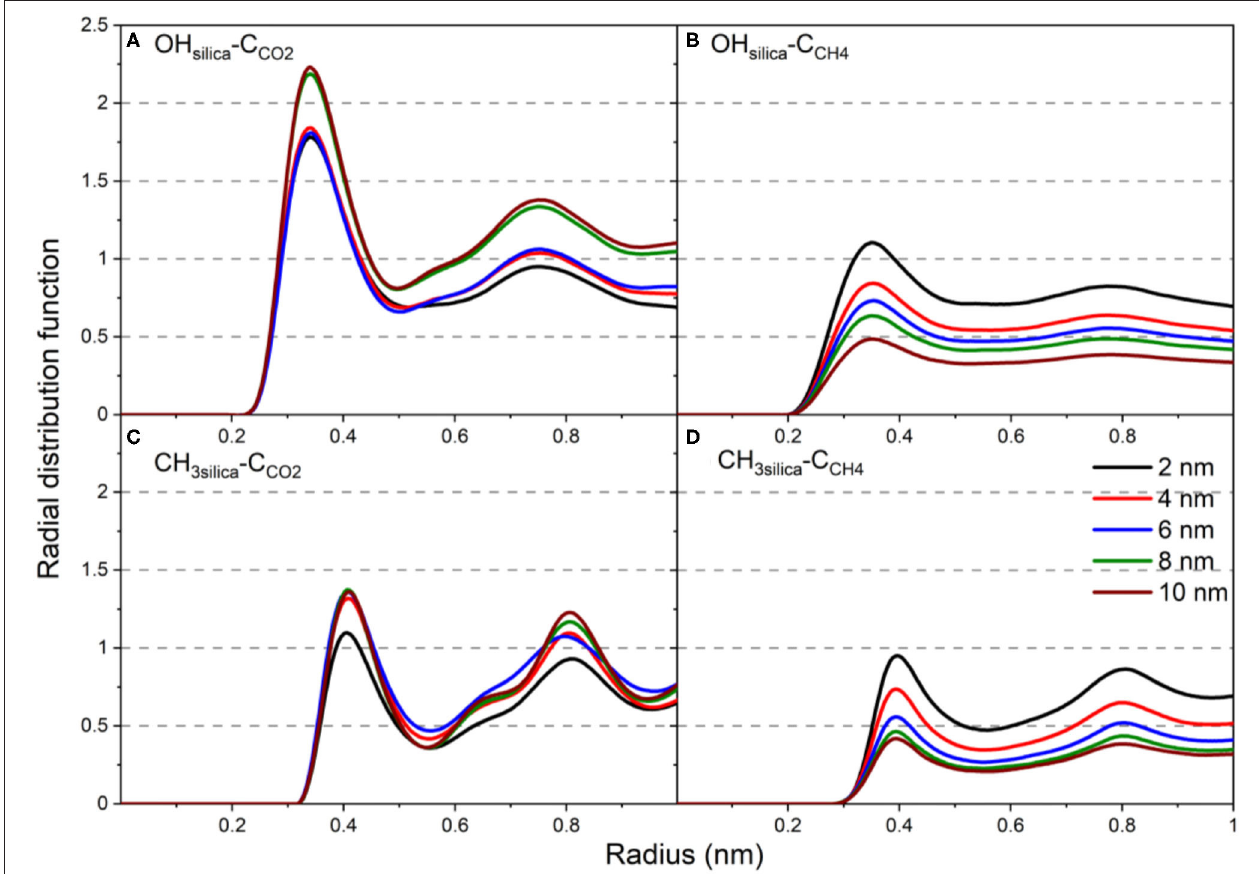
FIGURE 7 | The radial distribution function of (A) OH silica -C CO2 , (B) OH silica -C CH4 , (C) CH 3silica -C CO2 , (D) CH 3silica -C CH4 as a function of the pore diameter. Radial distribution functions are averaged over the last 10 ns of the simulation time.